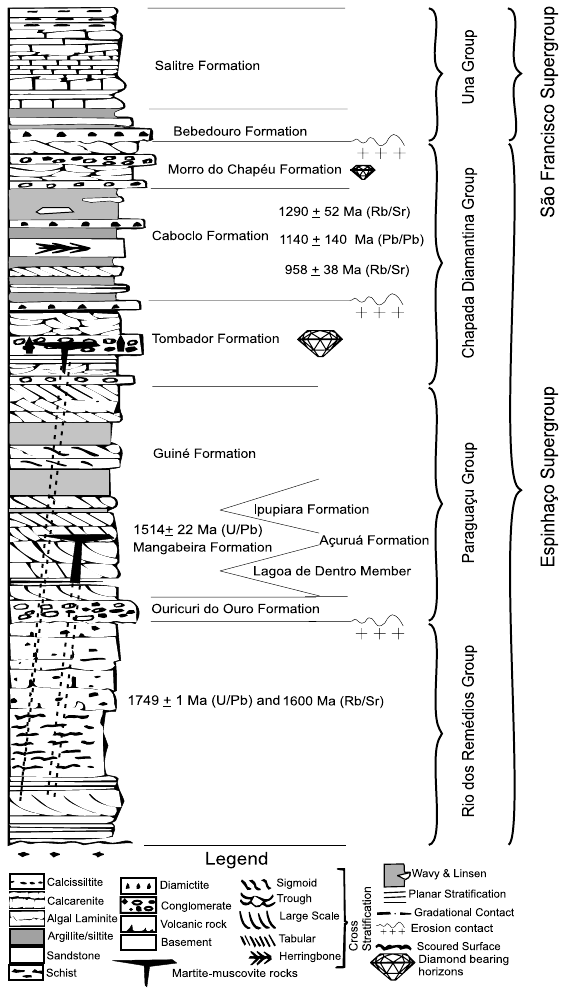
Fig. 2 – Schematic representation of the stratigraphic sequence of the EspinhaçoandSãoFranciscoSupergroupsintheChapadaDiamantina, Bahia area (modified from Rocha 1993).